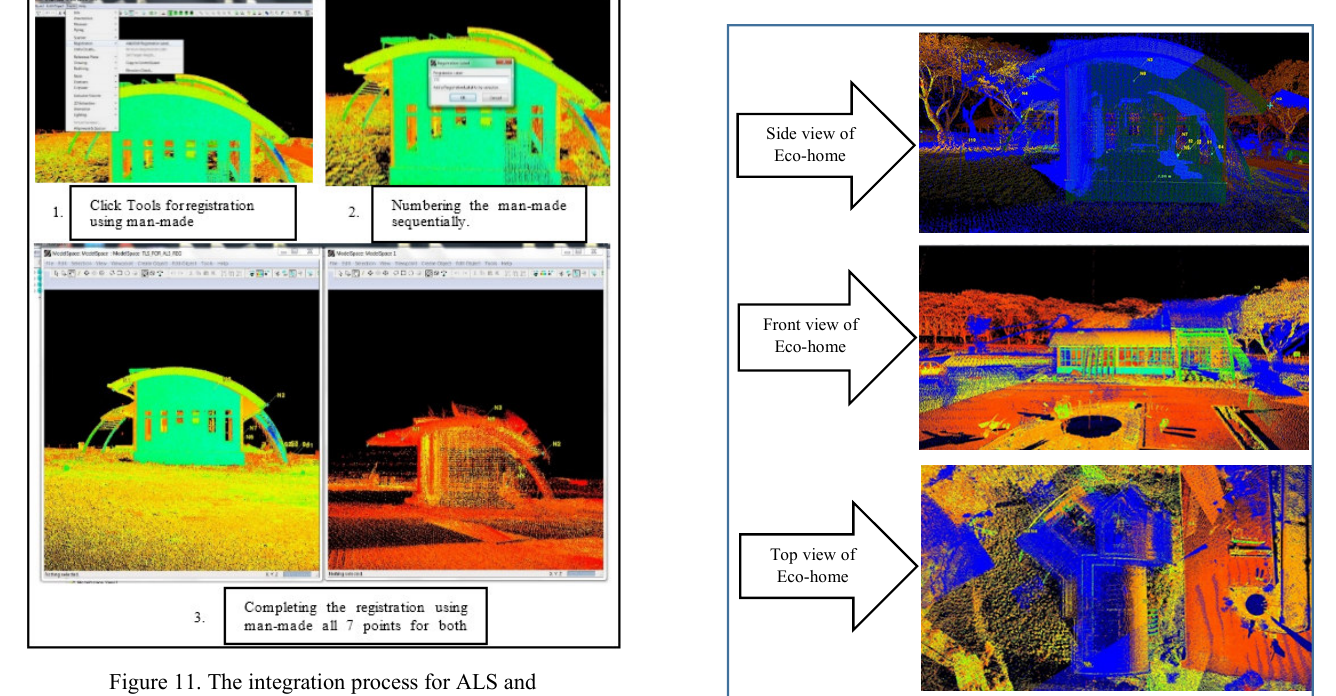
Figure 13. The integration of ALS and TLS result shows in different view of Eco-home